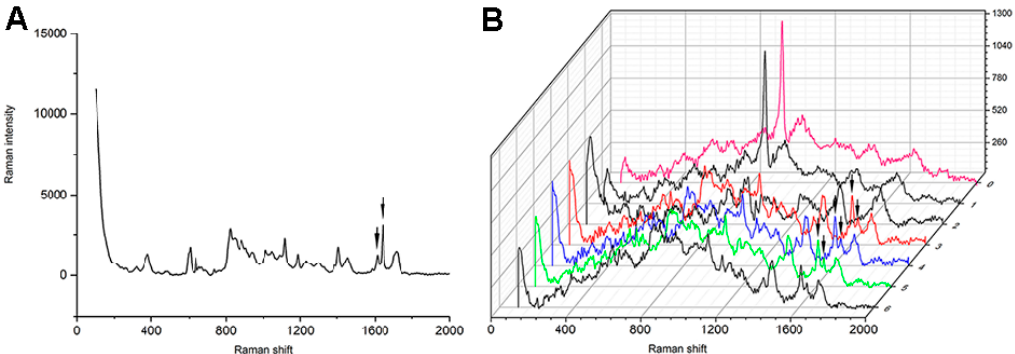
Figure 6. Micro-Raman spectrum of SB 2: The solid arrows represent the adhesive peaks before ( A ) and after ( B ) curing at the Raman shift of 1608 cm − 1 and at 1640 cm − 1 . The pink Raman spectrum is the representative spectrum of mineralized dentin; the red Raman spectrum is the representative spectrum of the adhesive at the bottom of the HL; the blue Raman spectrum is the representative spectrum of the adhesive at the middle of the HL; and the green Raman spectrum is the representative spectrum of the adhesive at the surface of the HL. HL, hybrid layer.